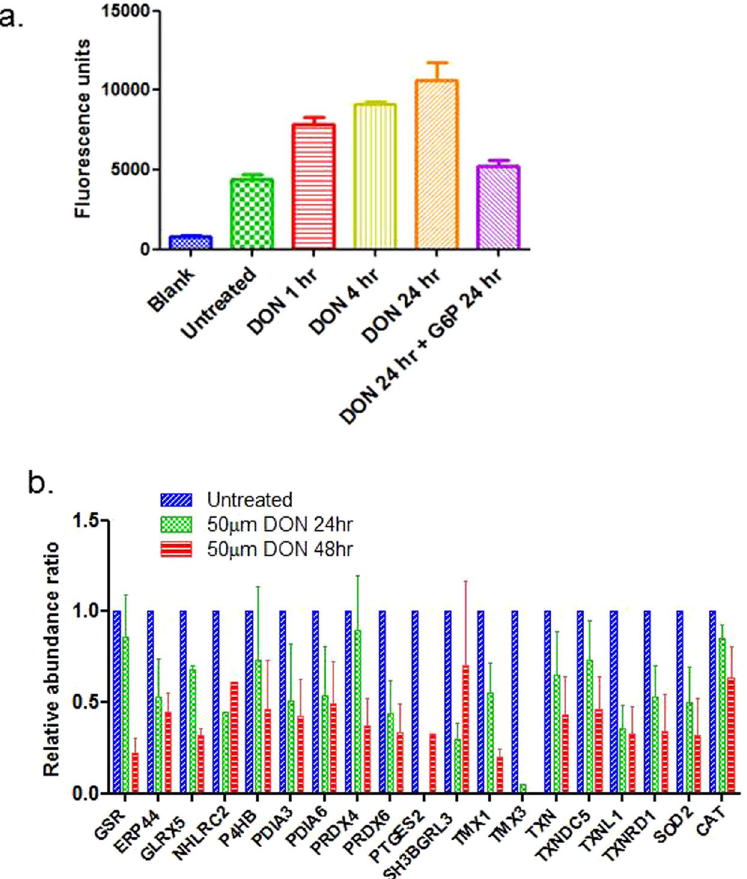
Figure 6. DON treatment imbalanced the redox state of GEM-R MiaPaCa cells. ( a ) GEM-R MiaPaCa cells treated with 50 µ m of DON showed increased ROS as the incubation time increased. Addition of G6P reduced the ROS level similar to the untreated cells. ( b ) The expression changes of proteins involved in cell redox homeostasis before and after incubation with 50 µ m of DON for 24 hr and 48 hr. The error bars represent SDs.